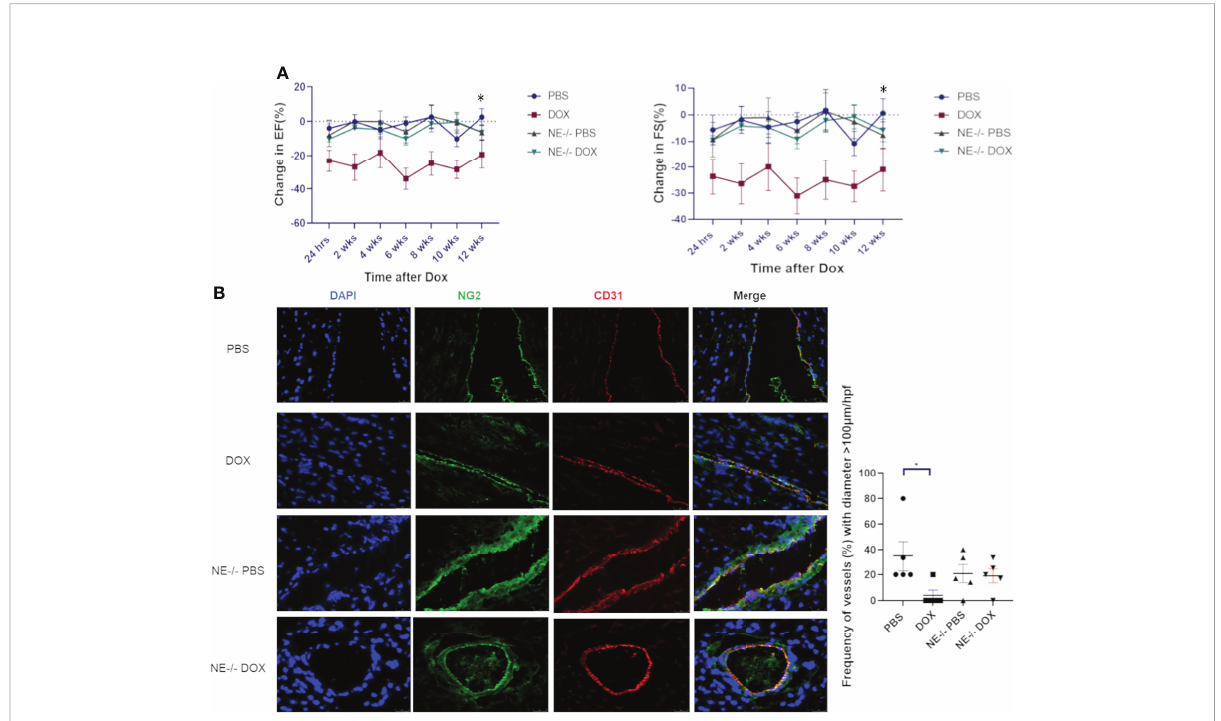
FIGURE 5 Effect of neutrophil elastase knockout (NE -/- ) on heart function and cardiac vessel morphology 12 weeks after therapy. (A) Ejection Fraction (EF) and fractional shortening (FS) were quanti fi ed by echocardiography and followed for 12 weeks after treatment with control phosphate-buffered saline (PBS) or doxorubicin (DOX) in wild-type and NE -/- mice; (B) Representative images of cardiac NG2 + and CD31 + vessels 12 weeks after therapy and frequency (%) vessels with >100µm/hpf. Data are presented as mean ± SEM, n = 5 each, * p < 0.05, one-way ANOVA analysis with Tukey comparison was used to compare the groups.